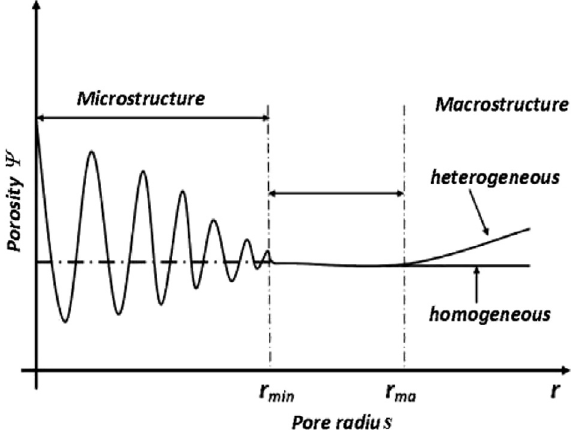
Figure 2. Porosity variation in porous medium at different